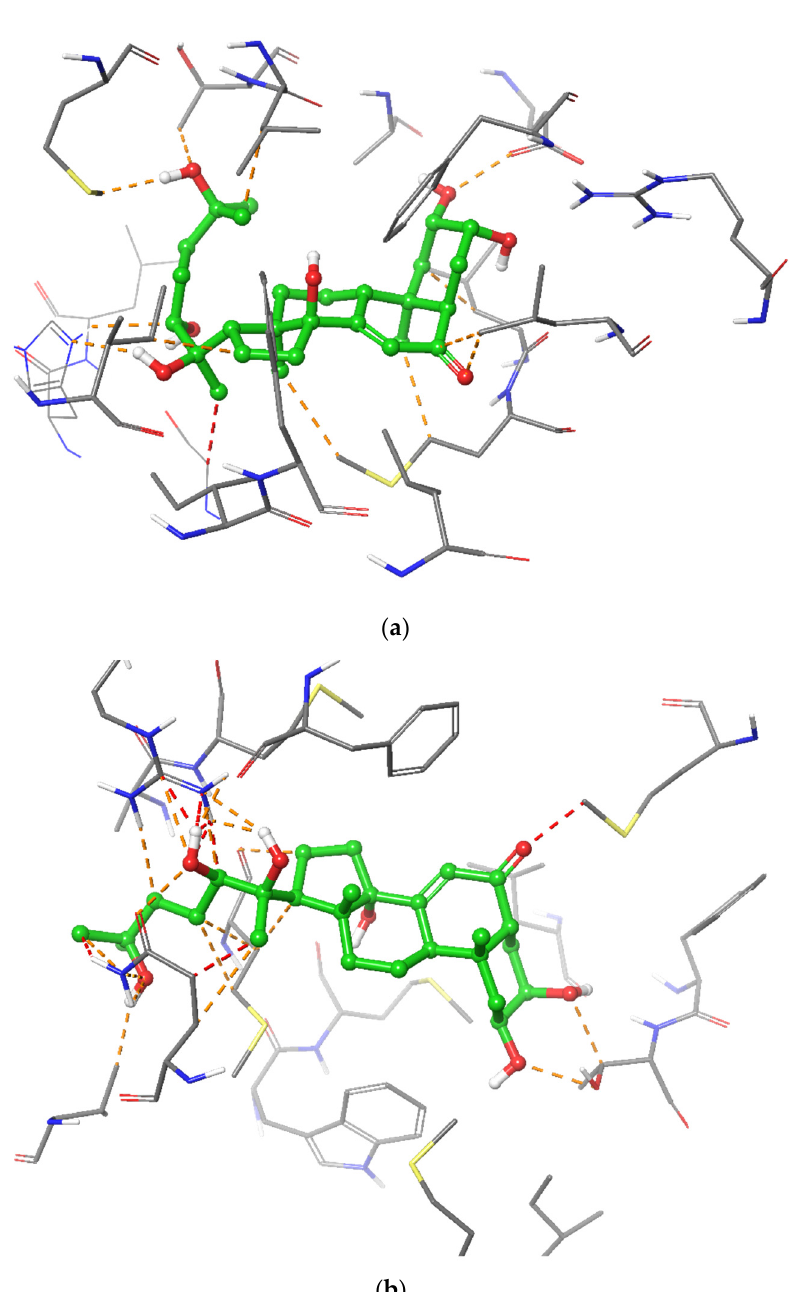
Figure 5. 2D diagram of the binding of 20-HE to the binding site of ER β .